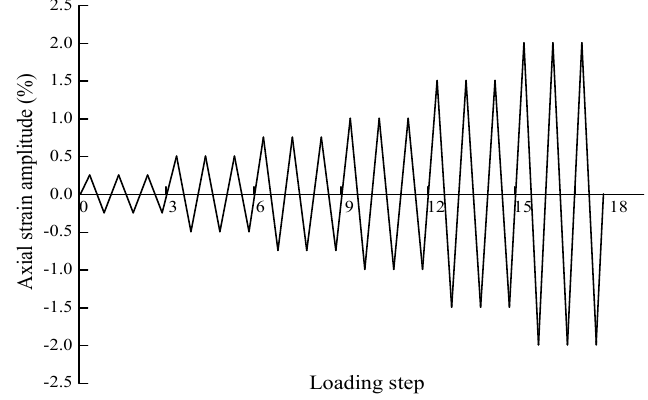
Figure 11. Hysteretic load protocol of CSA-BRBs.